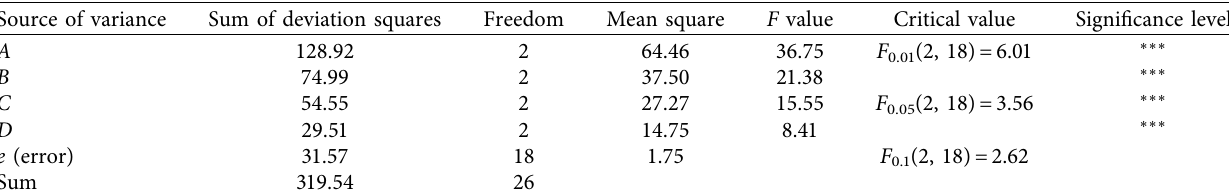
Table 4: Variance analysis of CFs yield.